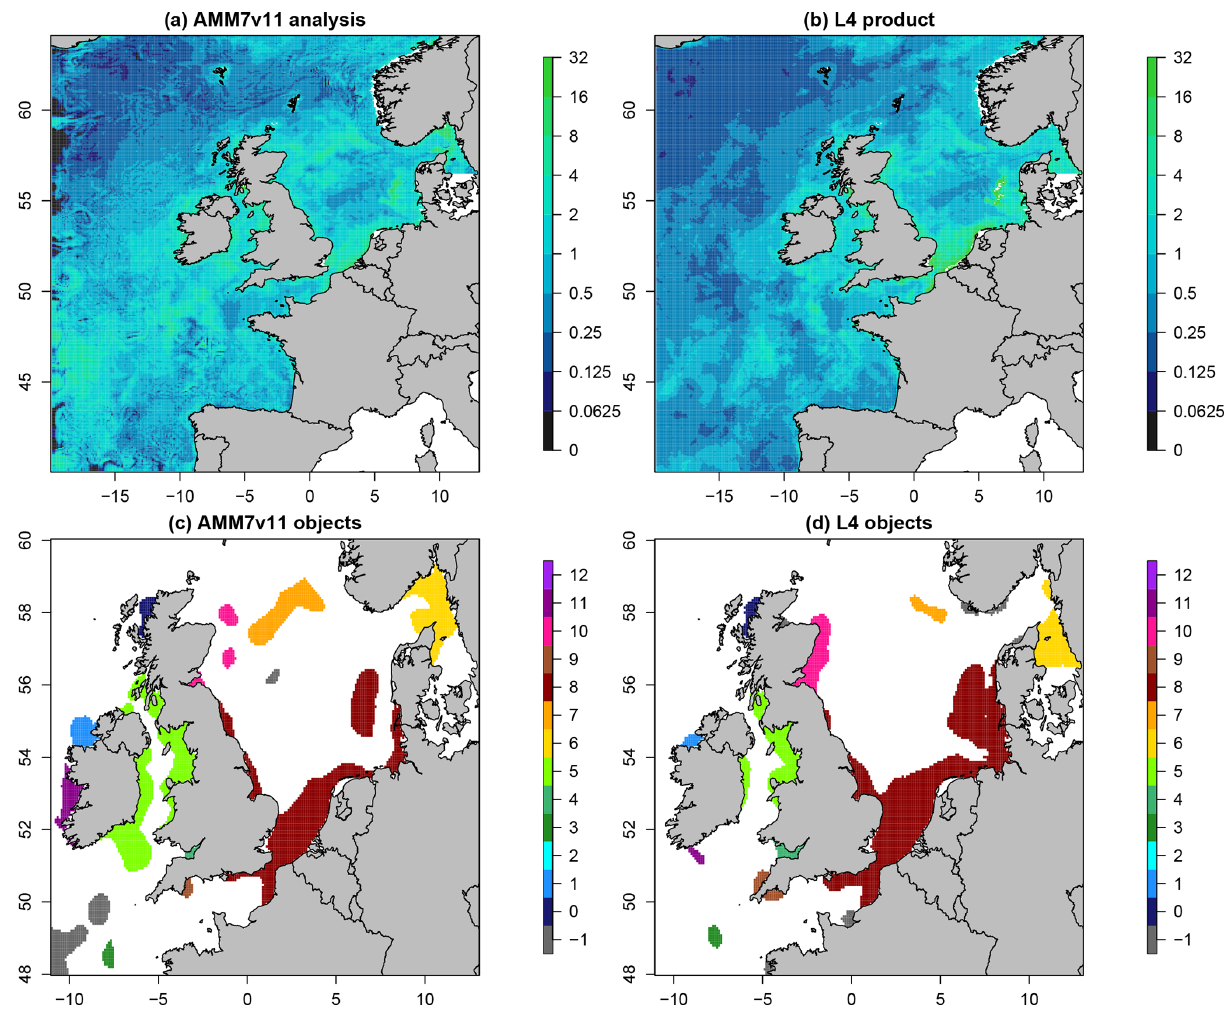
Figure 6. Daily Chl- a concentrations (in mgm − 3 for 21 April 2019: (a) AMM7v11 analysis and (b) L4 ocean colour product. The MODE objects shown in panels (c) and (d) are identified using a threshold of 6.3mgm − 3 and a smoothing radius of ∼ 21km. Note that panels (c) and (d) show a smaller (inner) domain. The colours show the matching clusters. Objects denoted with − 1 (grey) are